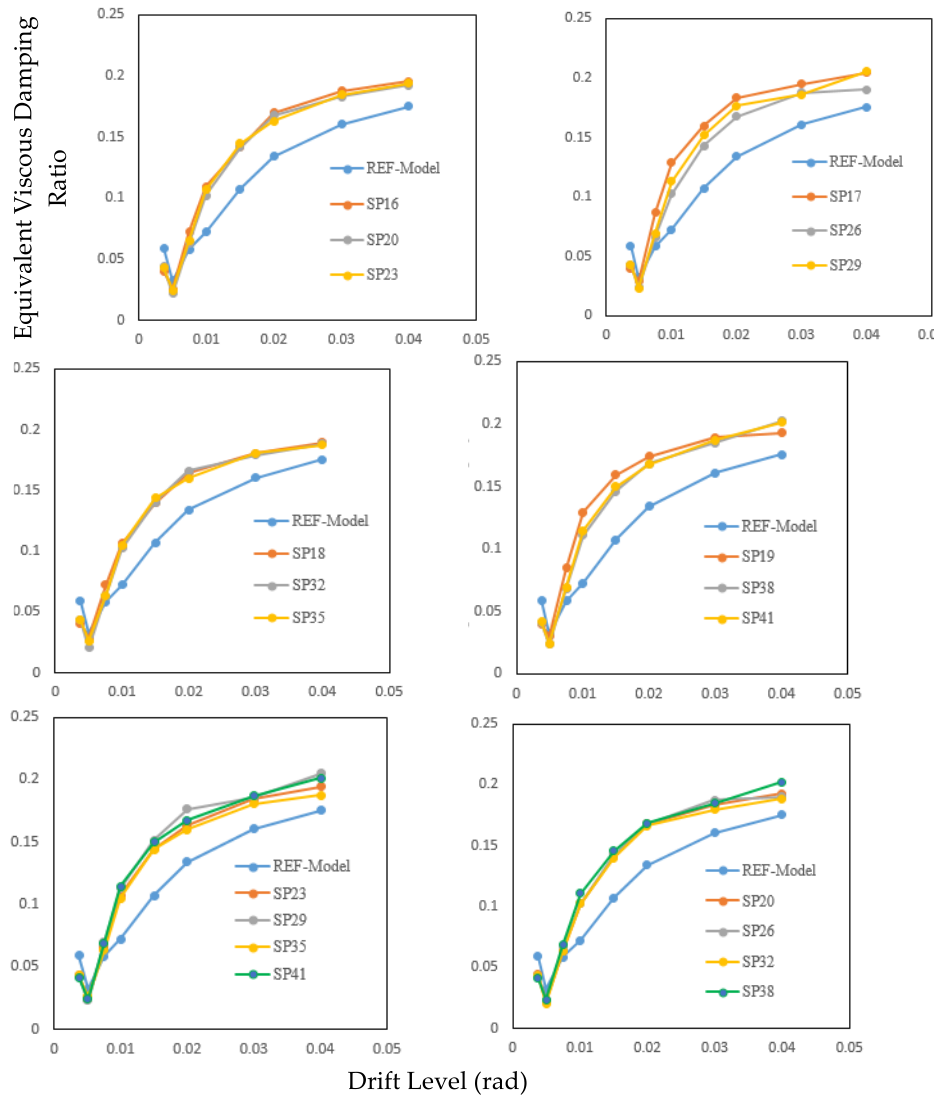
Figure 15. EVDR versus drift level.